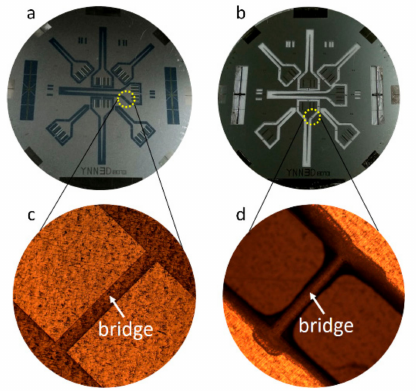
Figure 4. Optical photographs of the devices during the fabrication process. ( a ) A whole 4 in. substrate with fabricated TFTC arrays. ( b ) A whole substrate after the etching process. ( c ) An enlarged local area showing a narrow bonding bridge connecting the substrate and the 3D probe. ( d ) A close look at a bonding bridge after the etching process was completed, showing the probes still fixed in their original positions on the